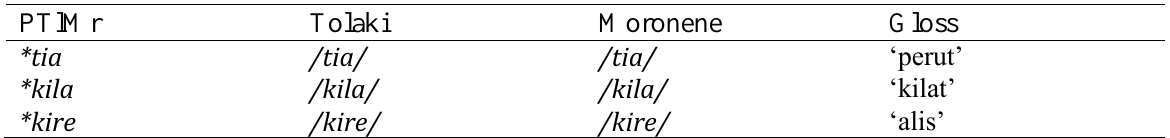
Table 5. The middle position of the word PTlMr